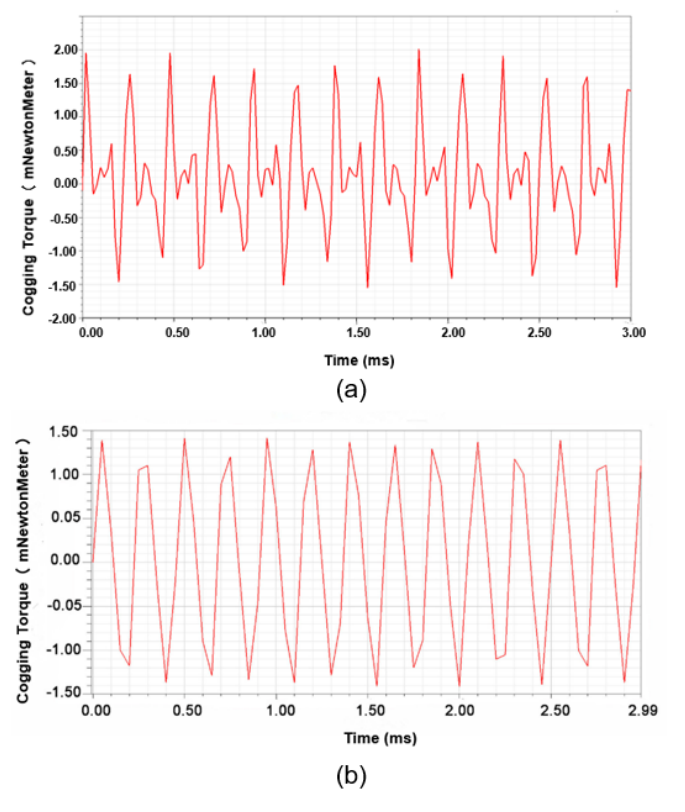
Figure 16. Plots of cogging torque ( a ) initial IPMBLDC motor model ( b ) optimized IPMBLDC motor model.